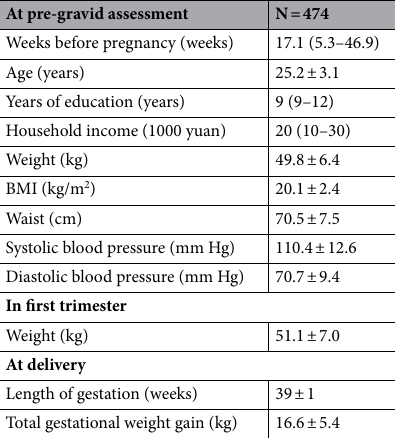
Table 1. Demographic and clinical characteristics of study population. Continuous variables are presented as mean ± standard deviation (if normally distributed) or median followed by interquartile range in parentheses (if